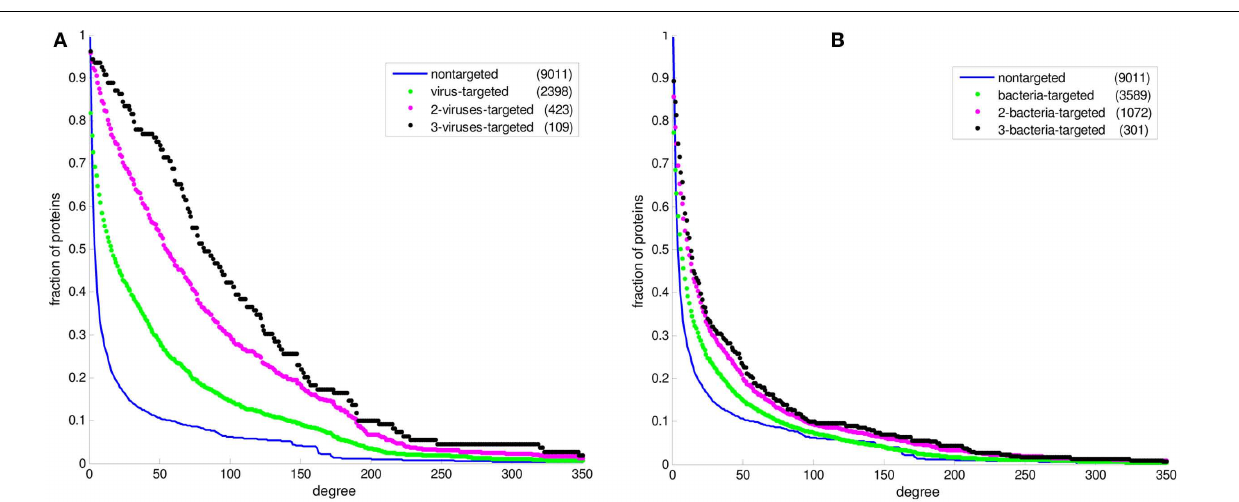
proteins in each set is given in the parentheses.The fraction of proteins at a particular value of degree is the number of proteins having that value and greater divided by the number of proteins in the set.